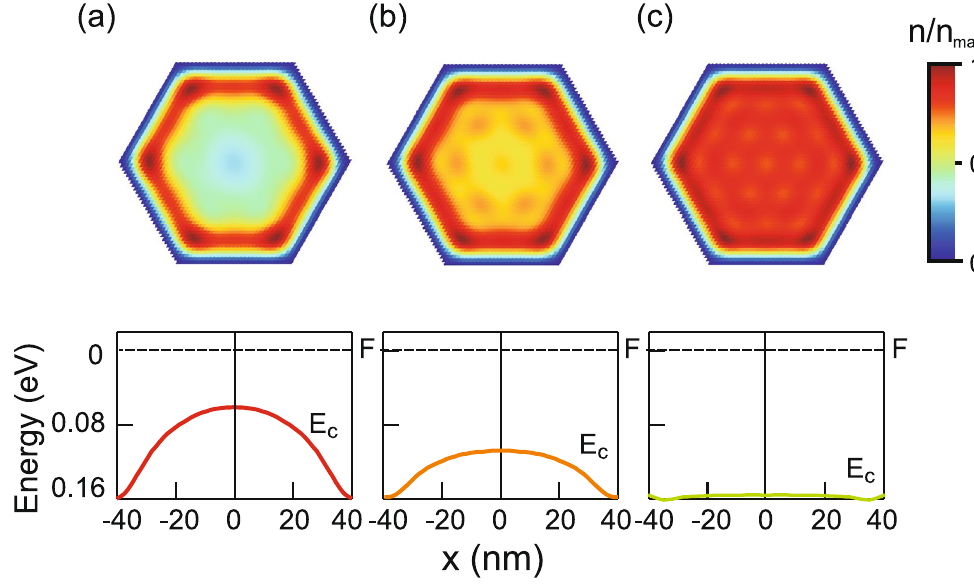
Figure 4. Upper: Two-dimensional electron distribution in a nanowire with a side length of 40 nm and the Fermi level positioned 0.16 eV above the conduction band edge at the surface; the n-type doping density is set to 5 × 10 17 cm − 3 ( a ), 10 18 cm − 3 ( b ), and 2 × 10 18 cm − 3 ( c ); T = 4 K. Lower: The conduction band diagram in the nanowire for the doping density indicated above.